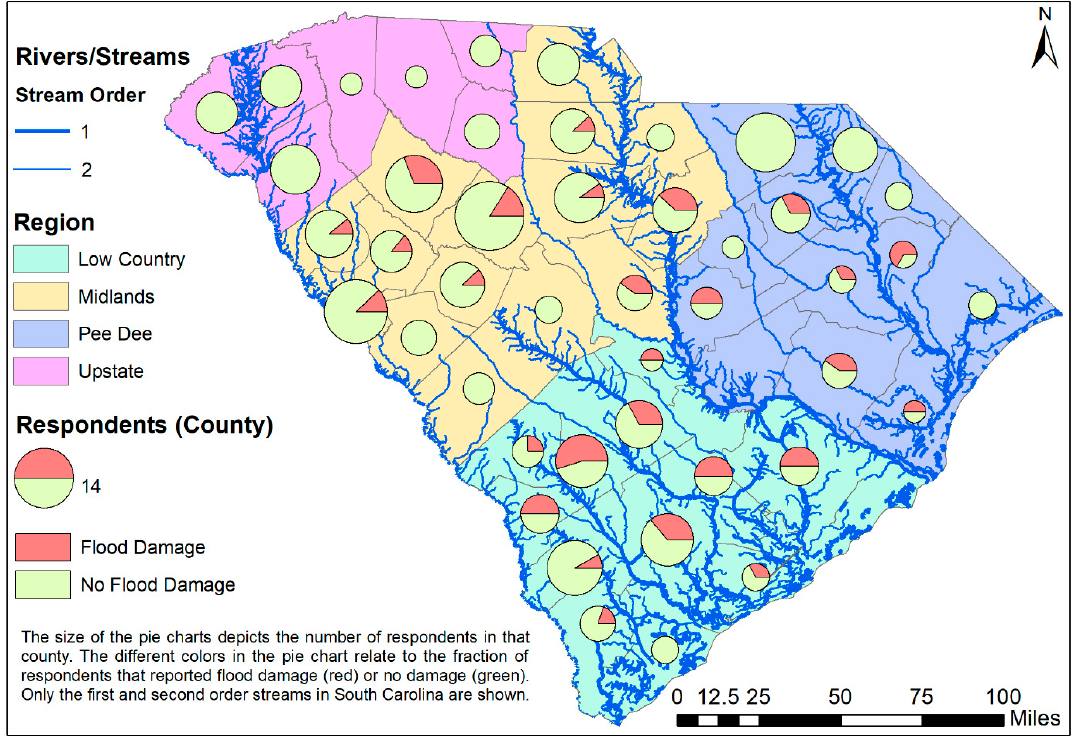
Figure 3. Frequency of reported damage from the 2015 flood event by county among South Carolina Tree Farmers in 45 counties (June–August 2017 data Tree Farmers in 45 counties (June–August 2017 data collection).